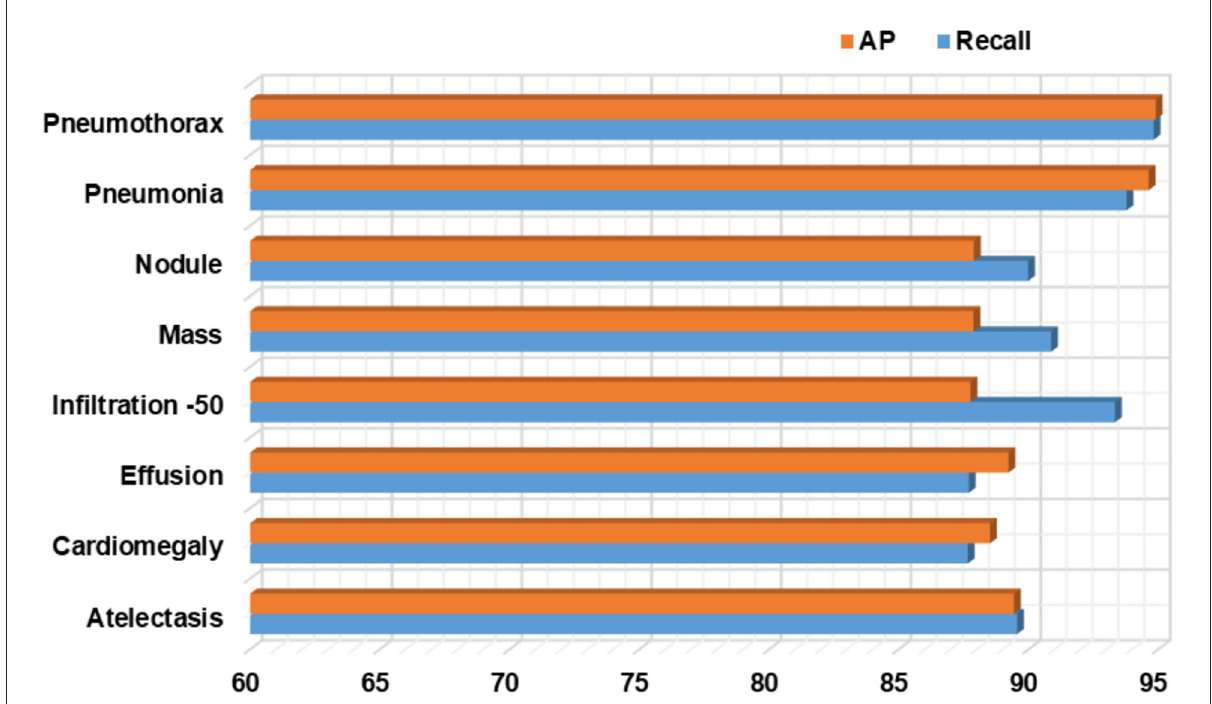
FIGURE11 Class-wise AP and recall values for the proposed Custom CenterNet